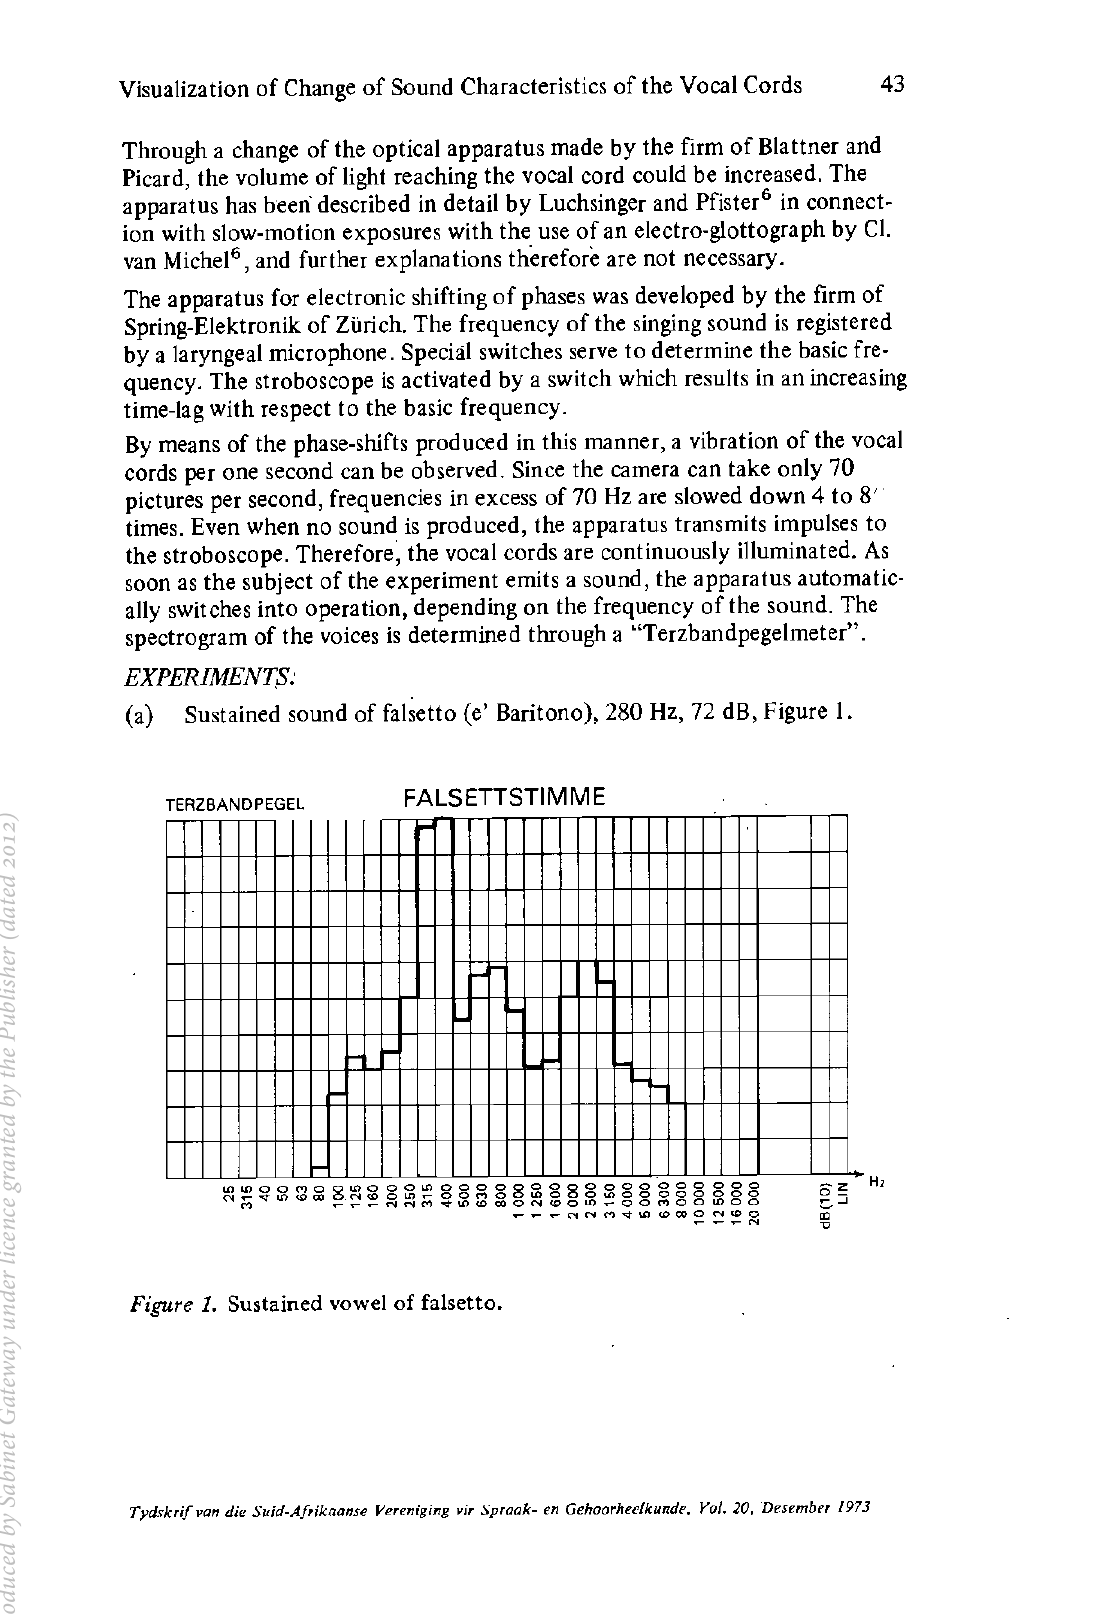
Figure 1. Sustained vowel of falsetto.